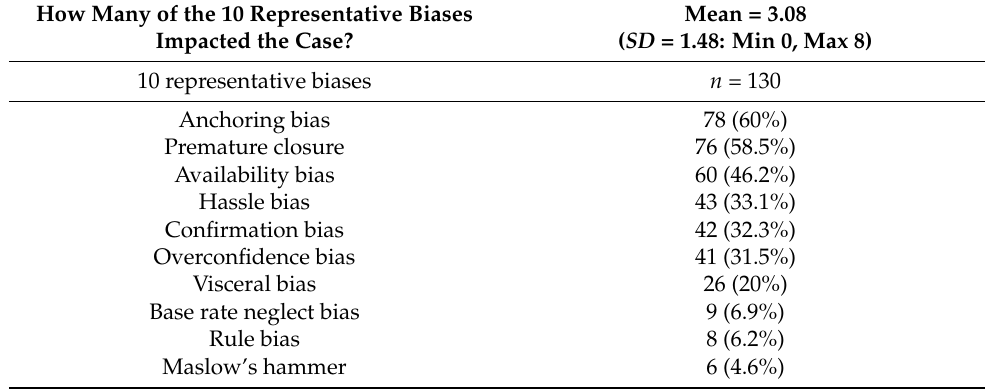
Table 4. Cognitive biases in diagnostic error cases that could be most vividly recalled and described. How Many of the 10 Representative Biases